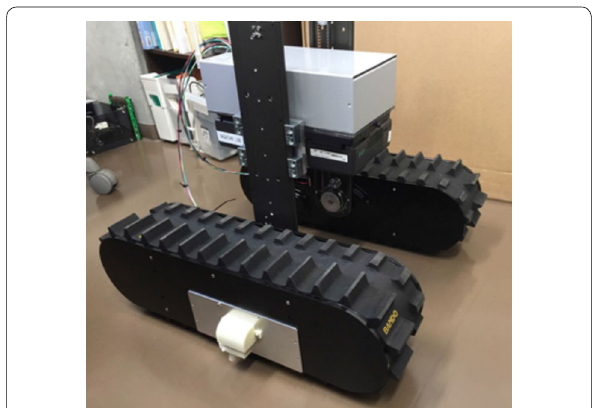
Fig. 6 Patako skid-steering tracked vehicle